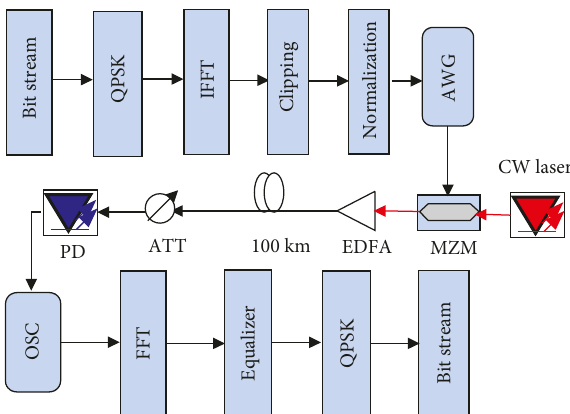
Figure 8: Experimental setup (EDFA: erbium-doped fiber am- plifier; ATT: attenuator; PD: photodiode; OSC: oscilloscope; AWG: arbitrary waveform generator; ATT: attenuator).